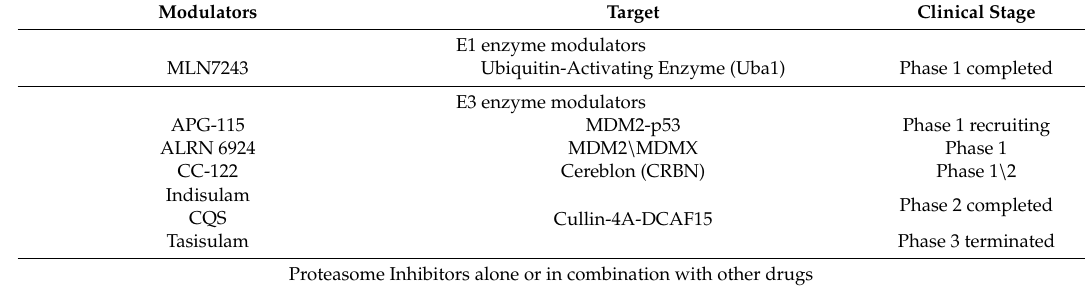
Table 1. Reported E1, E3, proteasome, deubiquitinase enzyme and aminopeptidase modulators in clinical trials.